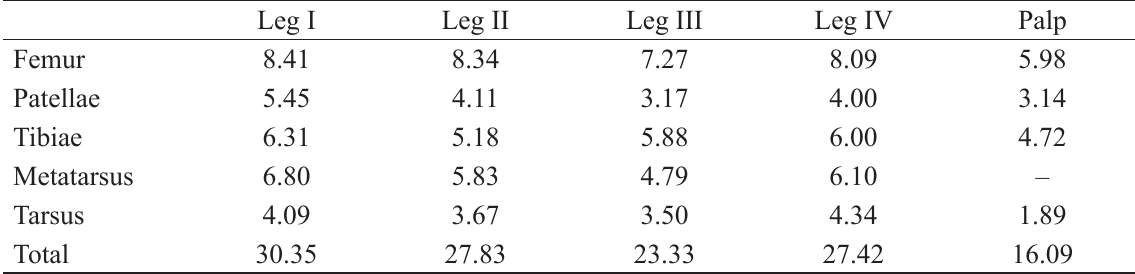
Table 3. Bistriopelma kiwicha sp. nov., holotype, ♂ (MUBI 12); length of palpal and leg